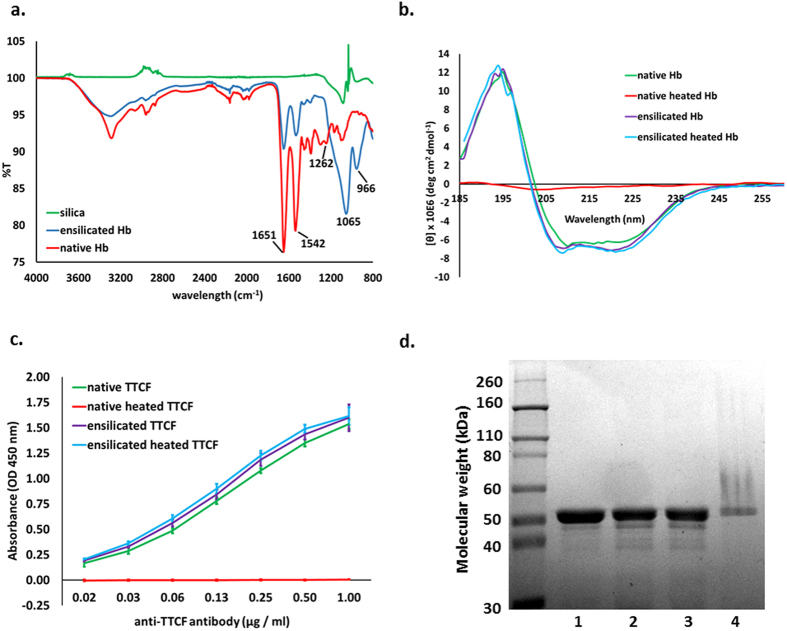
Structural data for ensilication of haemoglobin (Hb) and TTCF.(a) FT-IR data for Hb, silica, and ensilicated Hb (native Hb – red, silica – green and enslicated Hb – blue). The bands are as described in Fig. 2d. (b) Circular dichroism data on Hb samples: native Hb (green), native Hb after heat treatment (red), ensilicated Hb (purple), and Hb released from ensilication after heat treatment (blue). (c) TTCF antibody binding capacity before and after ensilication. ELISA binding assay was performed on native TTCF (green), native TTCF heated for 2 h at 80 °C (red), TTCF release from ensilication (purple) and ensilicated TTCF heated for 2 h at 80 °C and released (blue). Data are mean values and SEM, n = 3. Kruskal-Wallis non-parametric test comparison revealed no significant difference between the native TTCF and the two ensilicated and released samples (p = 0.834), but revealed a significant difference to the native heat-treated TTCF (p = 0.002). (d) SDS-PAGE analysis of TTCF. Lane 1 – native TTCF, Lane 2 – ensilicated and released TTCF, Lane 3 – ensilicated TTCF heated for 2 h at 80 °C and released, Lane 4 – TTCF heated in solution for 2 h at 80 °C. Representative images from 3 independent preparations.